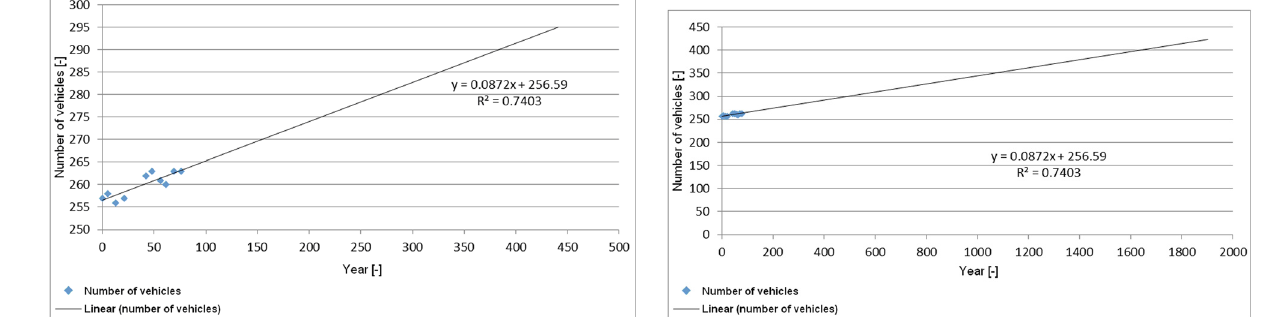
Figure 6: Parking demand forecast for 1 year. Figure 7: Parking demand forecast for 5